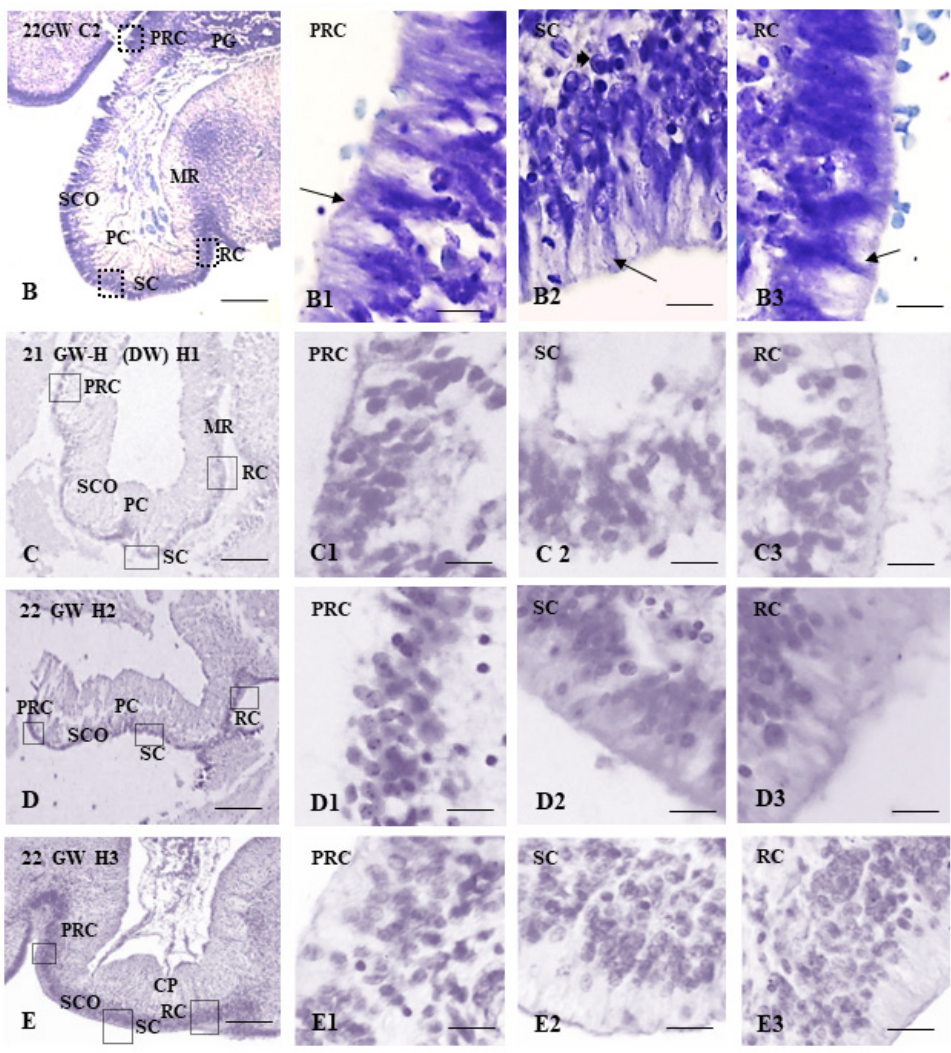
Figure 1. ( A ) Panoramic view of the SCO of a 21GW non-hydrocephalic control fetus ( C1 ), stained with hematoxylin-eosin (bar = 250 µ m). ( A1 ): precommissural part of the SCO (bar = 25 µ m), ( A2 ): subcommissural part of the SCO (bar = 25 µ m), ( A3 ): retrocommissural part of the SCO (bar = 25 µ m). ( B ) Panoramic view of the SCO of a 22GW non-hydrocephalic control fetus ( C2 ) (bar = 250 µ m), stained with cresyl violet. ( B1 ): precommissural part of the SCO (bar = 25 µ m), ( B2 ): subcommissural part of the SCO (bar = 25 µ m), ( B3 ): retrocommissural part (bar = 25 µ m). ( C ) Panoramic view of the SCO of a fetus with non-communicating hydrocephalus (Dandy–Walker) of 21GW (H1) (bar = 250 µ m), stained with hematoxylin-eosin. ( C1 ): precommissural part of the SCO (bar = 25 µ m), ( C2 ): subcommissural part of the SCO (bar = 25 µ m), ( C3 ): retrocommissural part (bar = 25 µ m). ( D ) Panoramic view of the SCO of a fetus with communicating hydrocephalus of 22 GW (H2) (bar = 250 µ m), stained with hematoxylin-eosin. ( D1 ): precommissural part of the SCO (bar = 25 µ m), ( D2 ): subcommissural part of the SCO (bar = 25 µ m), ( D3 ): retrocommissural part (bar = 25 µ m). ( E ) Panoramic view of the SCO of a fetus with communicating hydrocephalus of 22 GW (H3) (bar = 250 µ m), stained with hematoxylin-eosin. ( E1 ): precommissural part of the SCO (bar = 25 µ m), ( E2 ): subcommissural part of the SCO (bar = 25 µ m), ( E3 ): retrocommissural part (bar = 25 µ m). For all pictures: GW = gestational week MR = mesocoelic recess, PC = posterior commissure, PG = pineal gland, PRC = precommissural or rostral region of the SCO, RC = retrocommissural or caudal region of the SCO, SCO = subcommissural organ, SC = subcommissural or middle region of the SCO, ependymal cells, hypendymal cells.